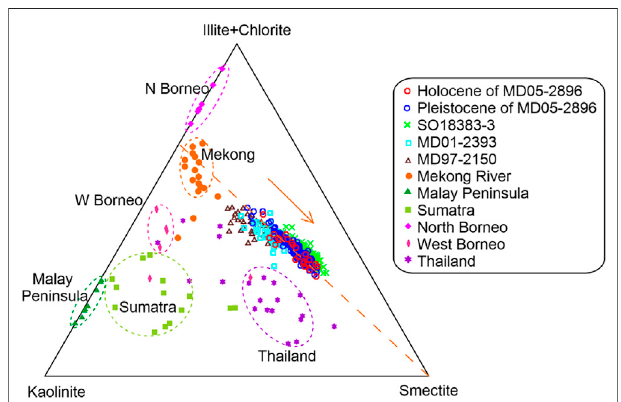
FIGURE 5 | Ternary diagram of the major clay-mineral groups: illite + chlorite, kaolinite, and smectite. Samples ofCore MD05-2896are divided into two groups: Holocene and Pleistocene. Surrounding river samples in the Mekong River, Borneo, Sumatra, the Malay Peninsula, and Thailand for potential sediment sources (Liu et al., 2007a; Liu et al., 2012; Liu et al., 2016) and sediment samples at referred Cores MD01-2393, MD97-2150, and SO18383-3 (Liu et al., 2004; Jiwarungrueangkul et al., 2019b) are plotted for comparison. Orange dashed line and arrow imply the major contribution from the Mekong River with increasing differential setting of